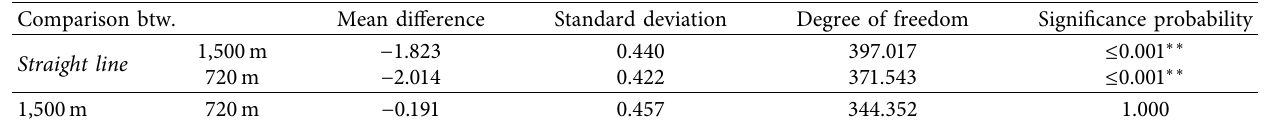
Table 12: Pairwise test results among curvatures on stabilization